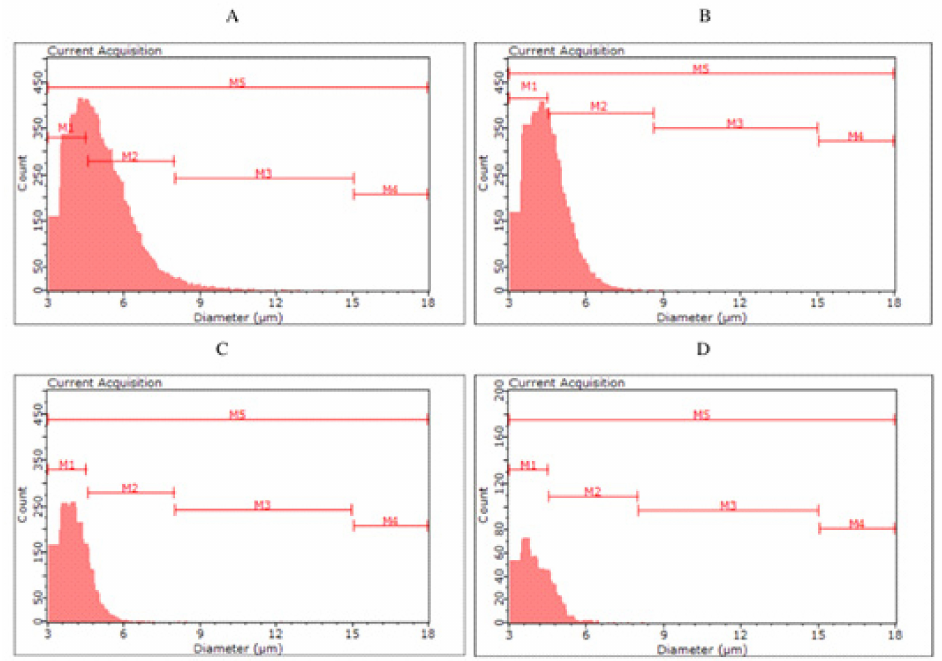
Figure 3. Histograms of yeast cell size in yeast biomass after main fermentation by Saccharomyces cerevisiae kveik (( A )—KVP, (( B )—KVD) and Saccharomyces cerevisiae var. diastaticus (( C )—SAP, ( D